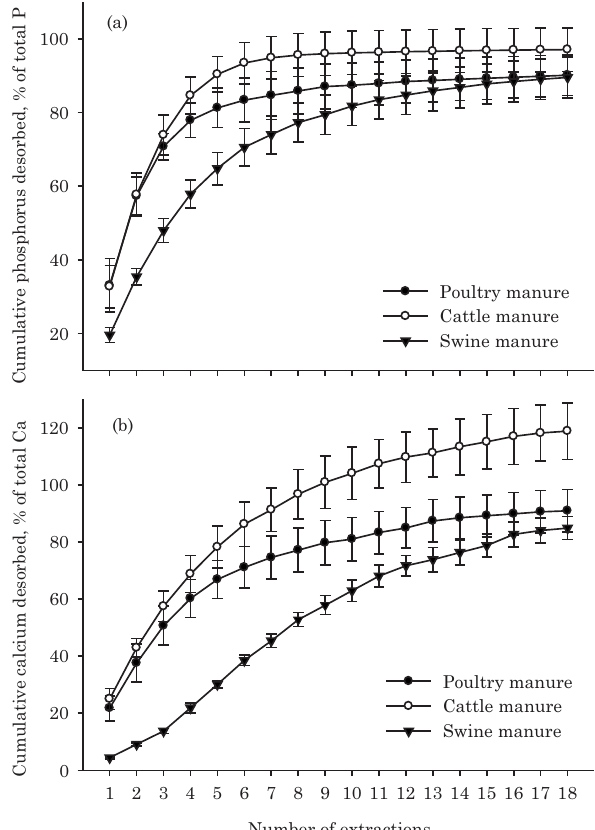
Figure 1. Cumulative phosphorus (a) and calcium (b) desorbed by successive anion-cation exchange resin extractions in poultry, cattle, and swine